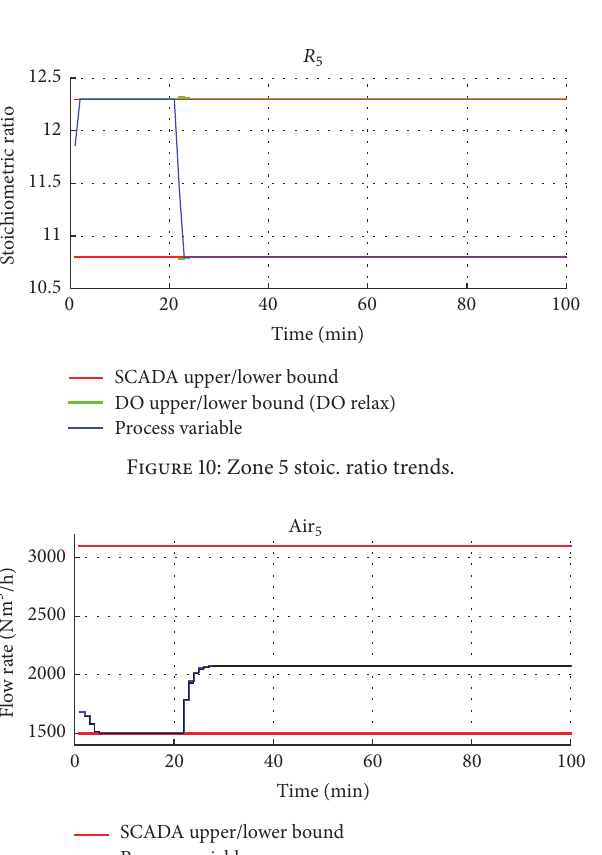
Figure 9: Zone 5 temperature trends.